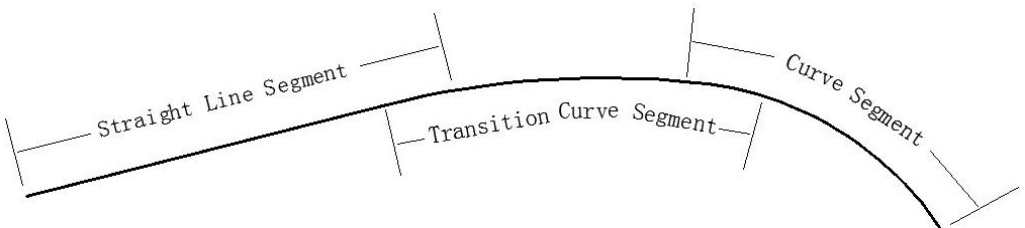
Figure 4. Segment-wise